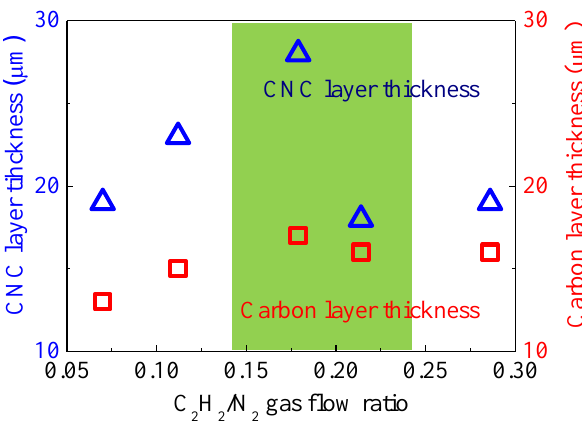
Figure 2. Thicknesses of CNC and carbon layers vs. C 2 H 2 /N 2 gas flow ratio. The flow rate of N 2 gas was fixed at 1400 mL/min, while that of C 2 H 2 gas was varied. The green-colored area represents the range for which the CNC purity in the CNC layer was